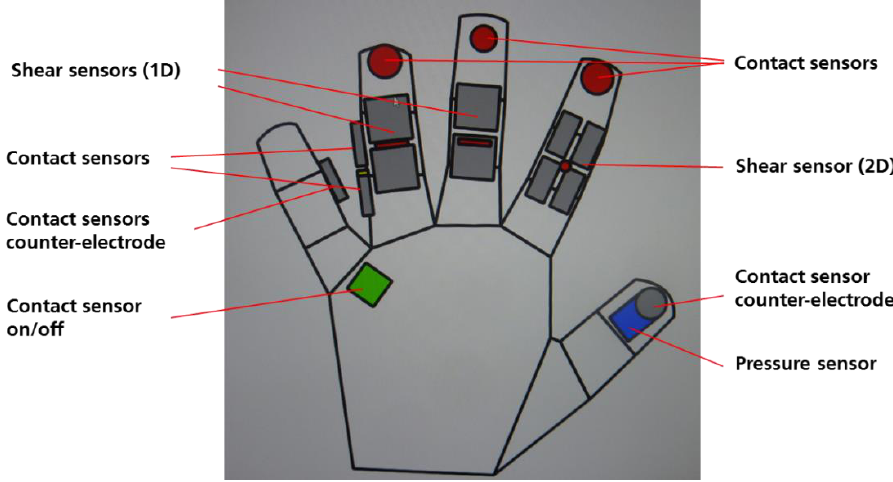
Figure 29. Schematic representation of an operating glove with two 1D and one 2D sliding or shear sensors, a pressure sensor and several contact sensors [106]. sensors, a pressure sensor and several contact sensors